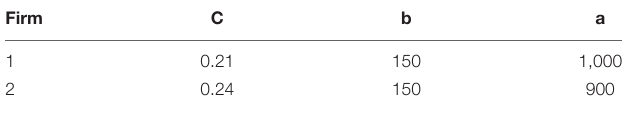
TABLE 2 | Cost parameters of power generators.